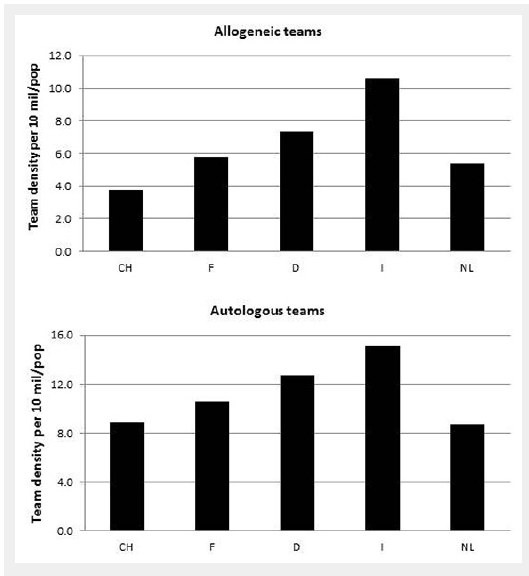
Figure 6 Transplant team density (number of teams per 10 million inhabitants). 6a: allogeneic HSCT. 6b: autologous HSCT (CH: Switzerland, F: France, D: Germany, I: Italy, NL: the